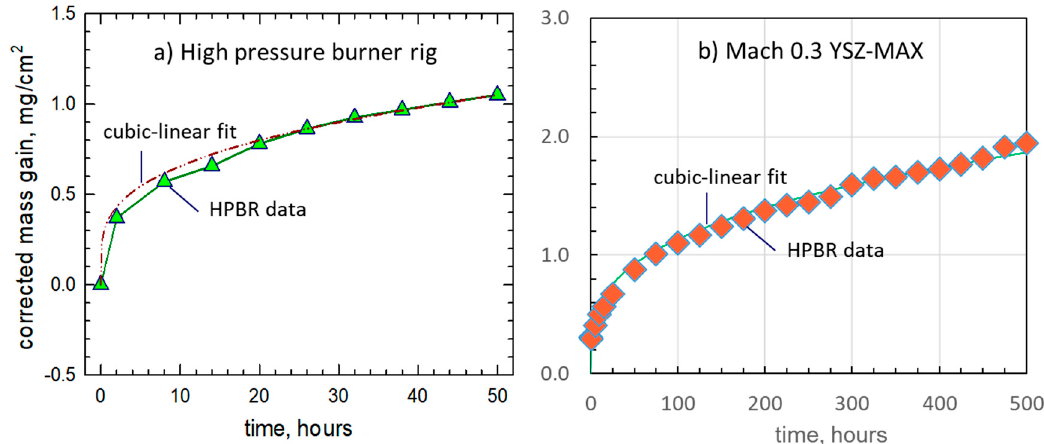
Figure 11. Cubic-linear fits to burner oxidation results for Ti 2 AlC: ( a ) high pressure (6 atm, 25 m / s, 1300 ◦ C). (COSP for Windows, k c = 0.212 mg 3 / cm 6 / h, Q = 0.220 mg / cm 2 / h, m = 3, α = − 3); ( b ) high velocity Mach 0.3 for YSZ / Ti 2 AlC (1 atm, 100 m / s, 1300 ◦ C). (COSP for Windows: k c = 0.050 mg 3 / cm 6 / h, Q = 0.038 mg / cm 2 / h, m = 3, α = −